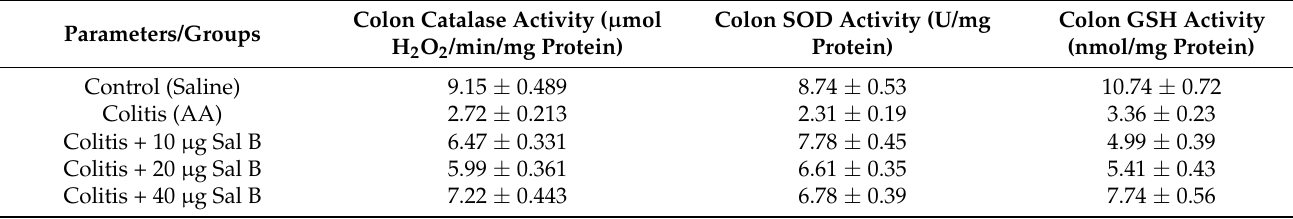
Figure 5. Effect of Sal B on enzymatic activities in mice colon tissue with AA-induced experimental colitis ( n =6). ( A ) Catalase activity, * p < 0.05, ** p < 0.01, *** p < 0.001 as compared with control, ( B ) Superoxide dismutase activity and ( C ) GSH level. The data are represented as mean ± SD and evaluated using one-way ANOVA, followed by Tukey’s multiple range tests for post hoc analysis. # p <0.05, ## p <0.01, ### p <0.001 as compared with control. Table 1. Effect of Sal B on colon catalase, SOD, and GSH